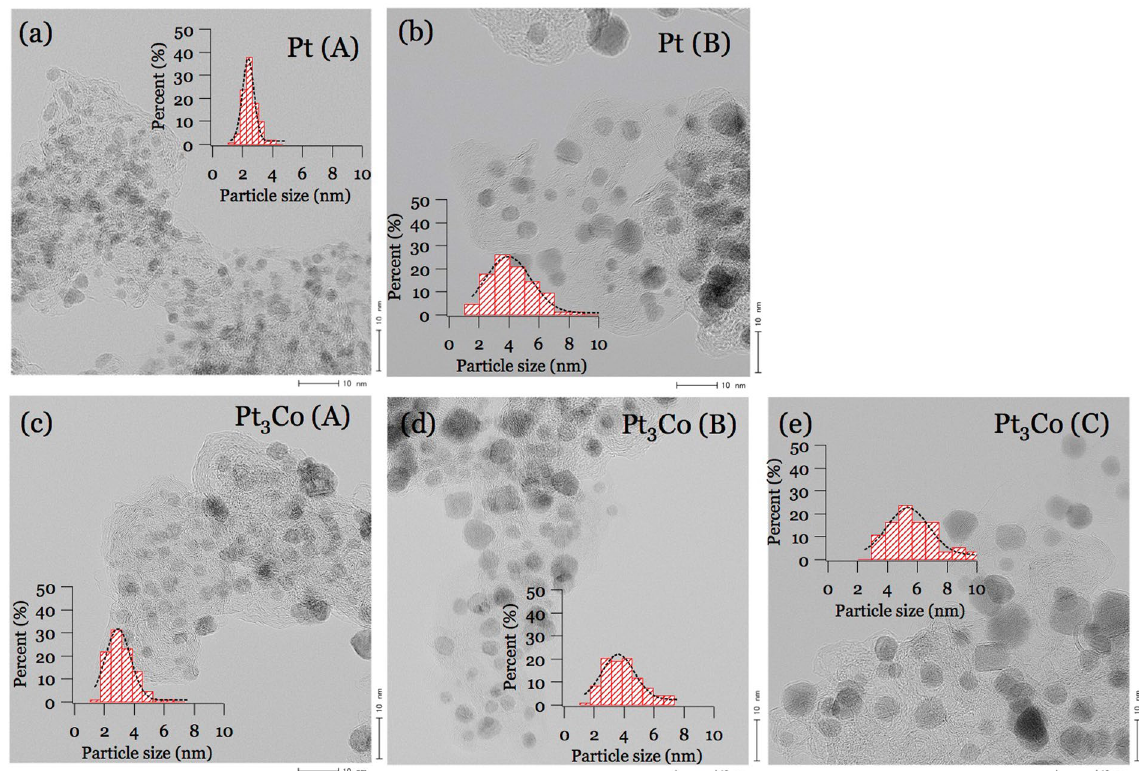
Figure 1. Typical TEM images of ( a ) Pt(A), ( b ) Pt(B), ( c ) Pt 3 Co(A), ( d ) Pt 3 Co(B), and ( e ) Pt 3 Co(C) samples. The inserts show the particle size distributions from TEM images.